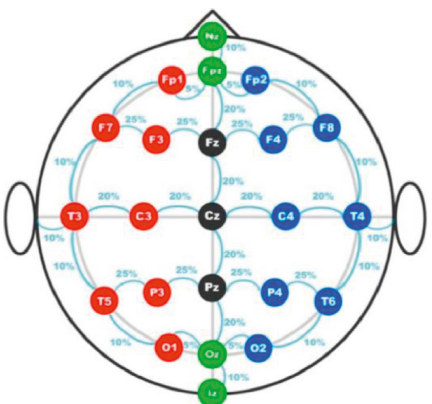
Figure 5: Sampling electrode placement diagram.